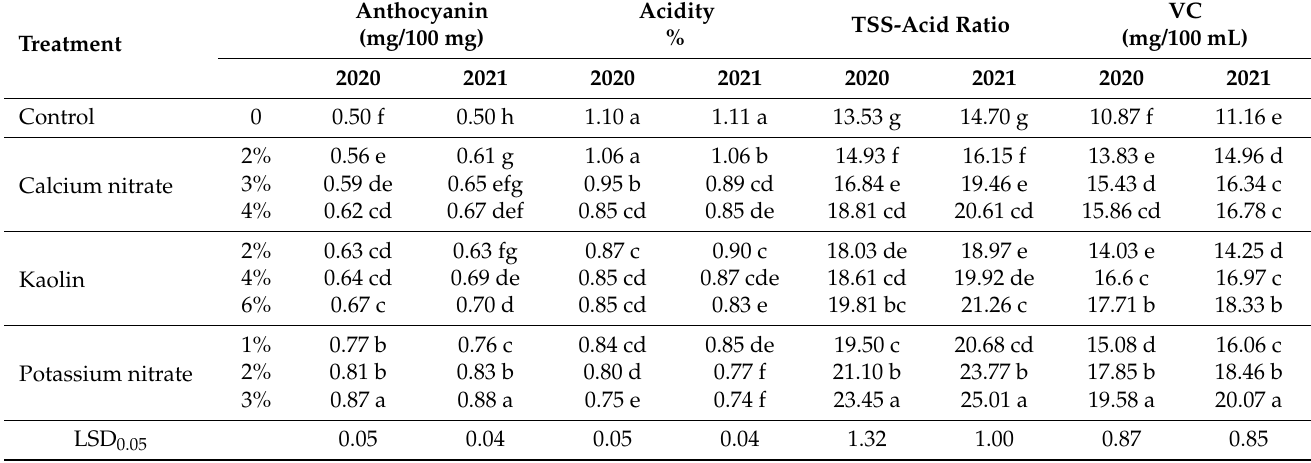
Table 7. The effect of the foliar application of potassium nitrate, calcium nitrate and kaolin on the fruit content from anthocyanin, acidity, TSS-Acid ratio and vitamin C of ‘Wonderful’ pomegranates during the 2020 and 2021